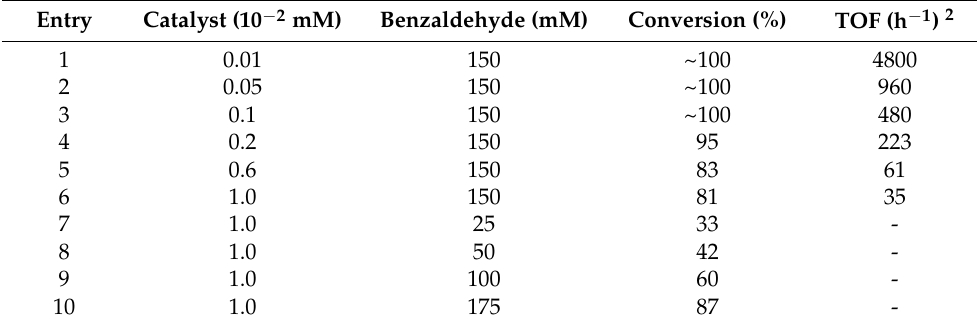
Table 2. Dependence between the conversion and number of turnover values on the catalyst ( 2 ) and benzaldehyde concentrations for the iron(II)-catalyzed Baeyer–Villiger oxidation of cyclohexa- none by molecular oxygen in the presence of benzaldehyde. 1